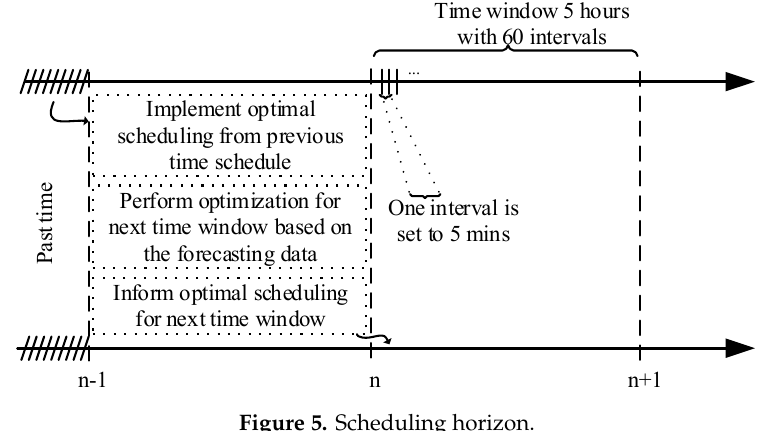
Figure 4. Tested WF system configuration.